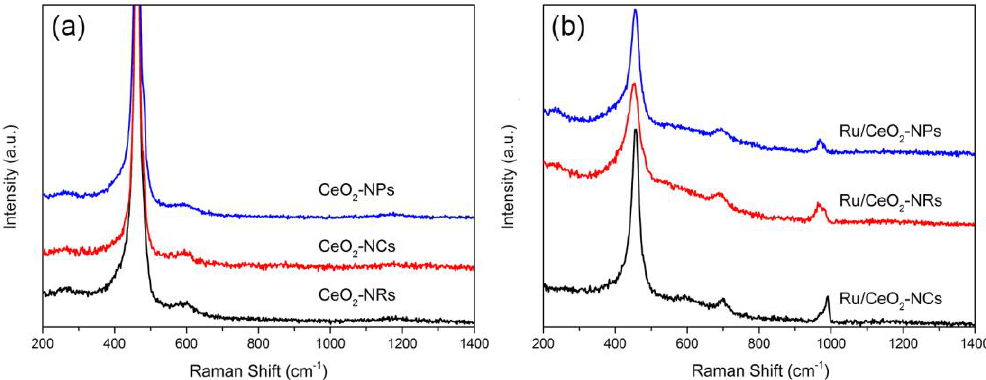
Figure 4. Raman spectra of ( a ) CeO 2 samples ( b ) Ru/CeO 2 samples. Table 2. Raman spectral data of CeO 2 and Ru/CeO 2 samples.